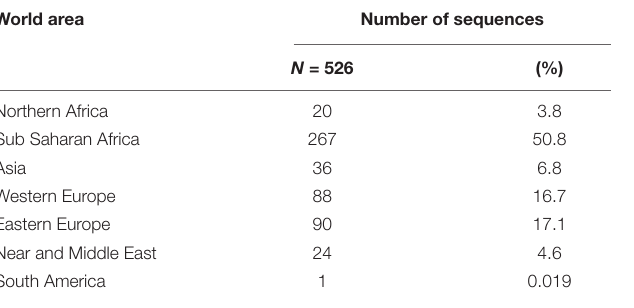
TABLE 1 | Number of HBV genotypes obtained among the 1,590 clinical strains according to the geographic origin of the patients. World area